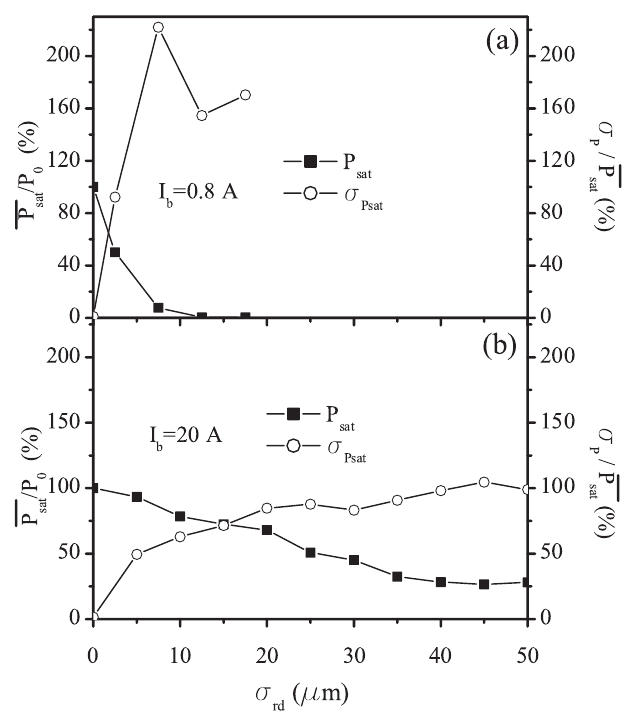
=P ) and normalized sat 0 =P ) as a function of the standard P sat for a weak pump current rd